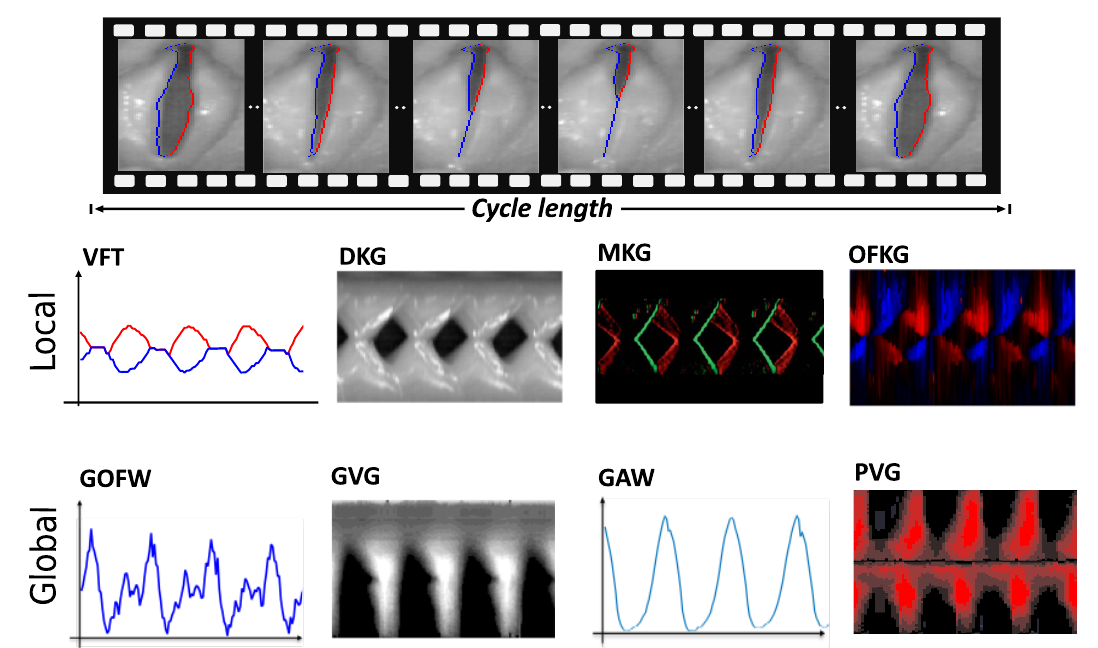
Figure 9. Eight Facilitative Playbacks (FP) proposed in the literature. Vocal Folds Trajectories (VFT), High-Speed Digital Kymograghy (DKG), Glottal Area Waveform (GAW), Glottal Optical Flow Waveform (GOFW), High-Speed Digital Kymograghy (DKG), Glottovibrogram (GVG), Mucosal Wave Kymography (MKG), Optical Flow Kymogram (OFKG), Phonovibrogram (PVG), Glottaltopogram (GTG), illustrated on the same highspeed